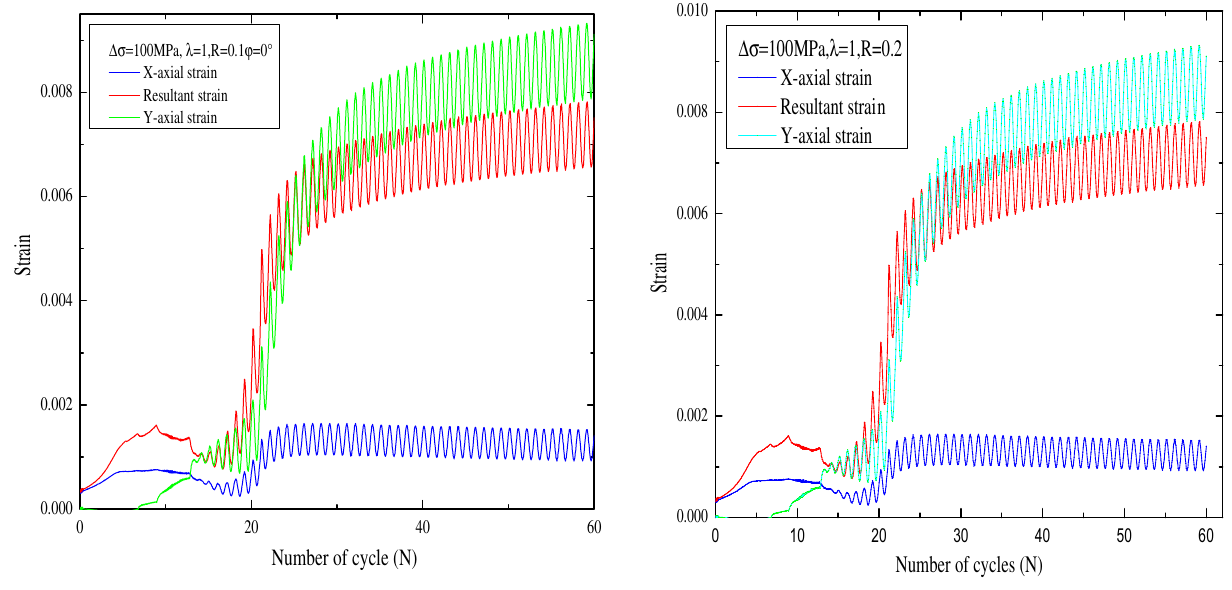
Fig. 8 Relationship curves of strain and cycle numbers for test specimen under different biaxial proportional low-cycle fatigue